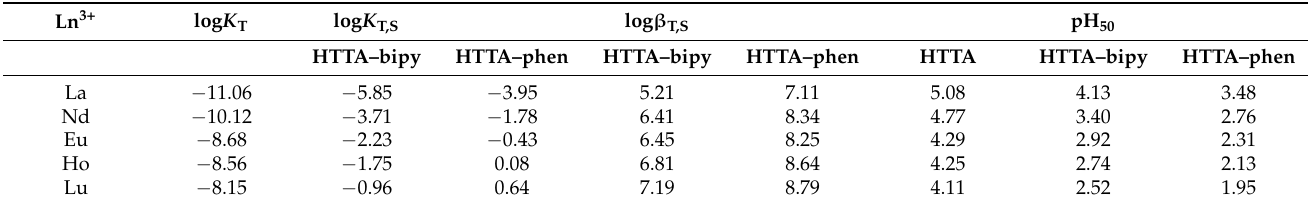
Table 7. Values of the equilibrium constants K T , K T,S , and β T,S , and pH 50 for the extraction of lanthanoid ions with HTTA and HTTA–S systems in CHCl 3 . Reprinted with permission from Ref. [132].